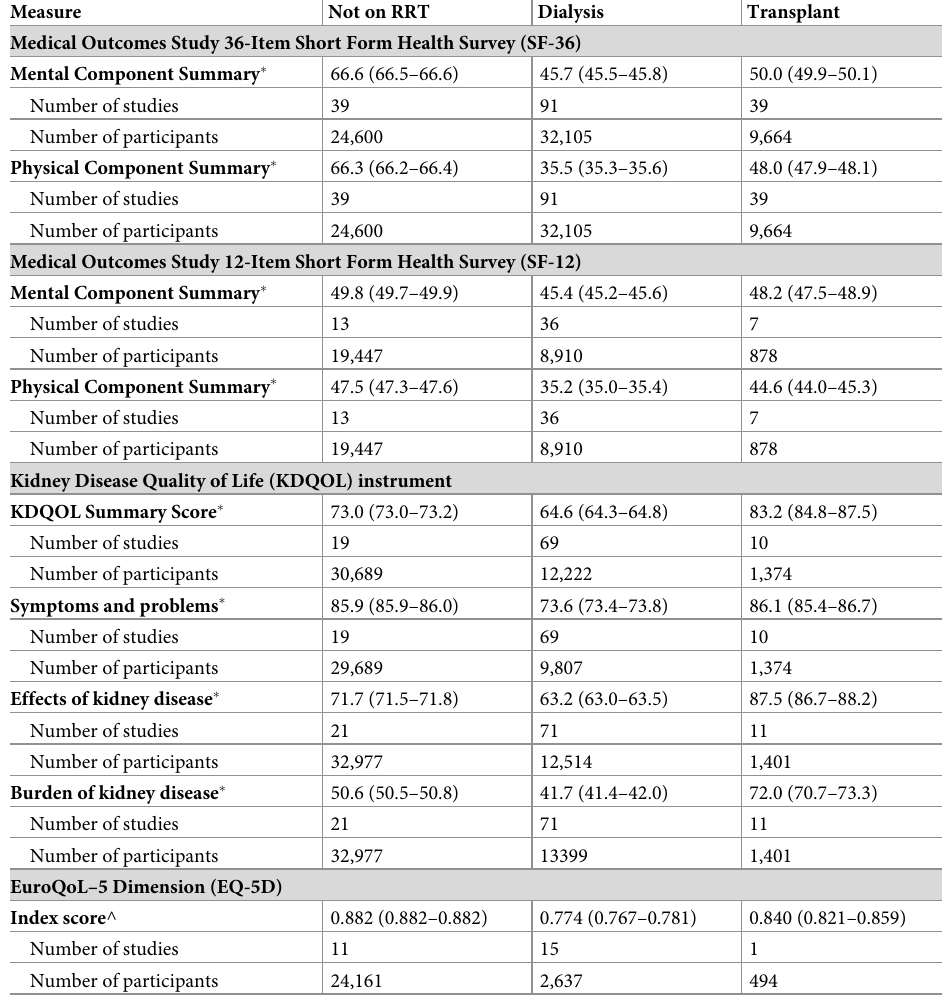
Table 3 AU : InTable 3 : Irearrangedtherowsandformattedthefirstcolumn ð viaindenting Þ tomakeclearwhichmeasureeachnumberofstudiesandnumberofparticipantsbelongedto : ð NotethatthisincludedduplicatingthenumberofstudiesandnumberofparticipantsinformationfortheMCSandPCSmeasures : Þ Pleasecheckthatallinformationiscorrectlyassigned : Ifnot ; pleaseeditasnecessary : . Health-related quality of life outcomes in chronic kidney disease. Measure Not on RRT